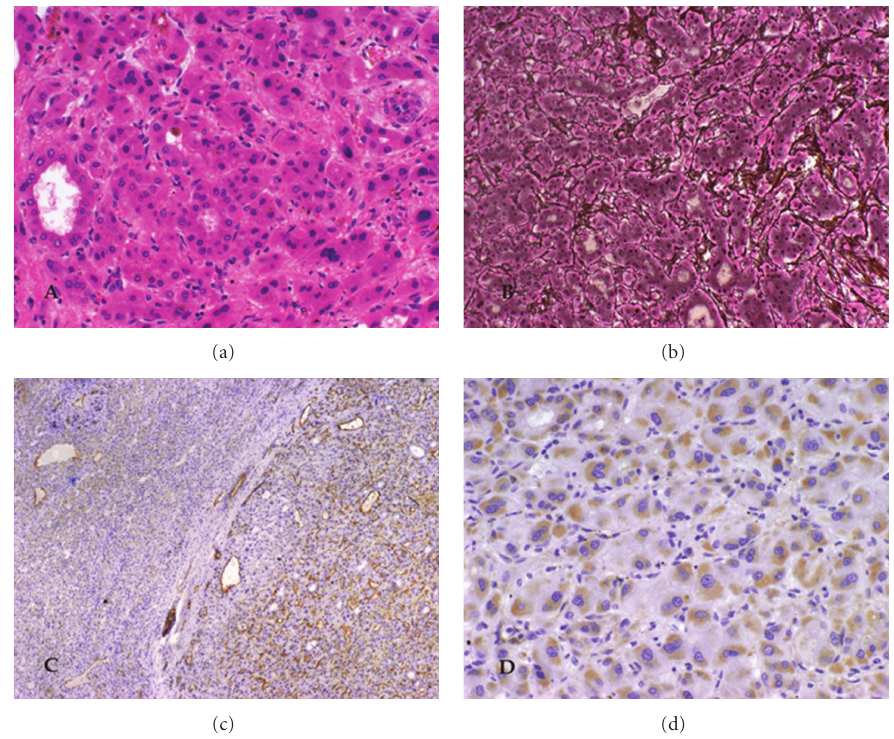
Figure 2: Histological features of hepatocellular carcinoma in a noncirrhotic liver. (a) Hepatocellular carcinoma with pseudoglandular pattern and bile production. (b) Loss of reticular fibres and cord thickening up to six cells. (c) Immunohistochemical staining for CD 34. (d) Positive immunohistochemical staining for glypican